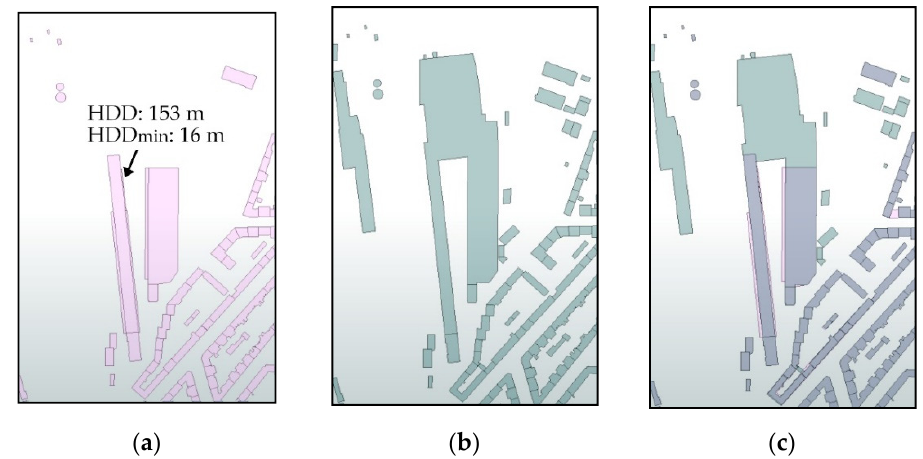
Figure 5. Example of Hausdorff Distance ( HDD ) and the minimum function of Hausdorff Distance ( HDDmin ) for a large, changing building complex where the intersection areas have not changed in reality: ( a ) buildings at time 1; ( b ) buildings at time 2; ( c ) buildings from time 1 and time 2 are over- laid.